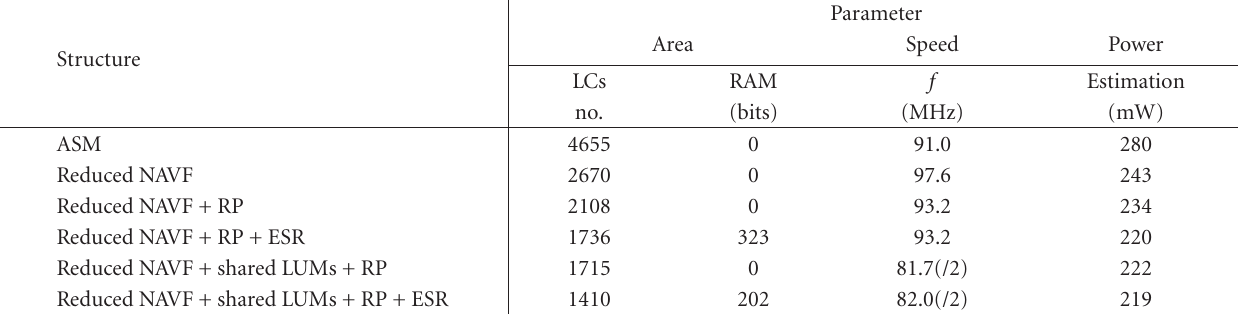
Table 7: Mapping of the ASM scheme and the proposed reduced NAVF scheme into Altera STRATIX EP 1S25-5 device using Quartus II v. 4.1 compiler and fitter. The reduced NAVF scheme has been implemented using the pipelined structure without and with register packing (RP) and embedded shift registers